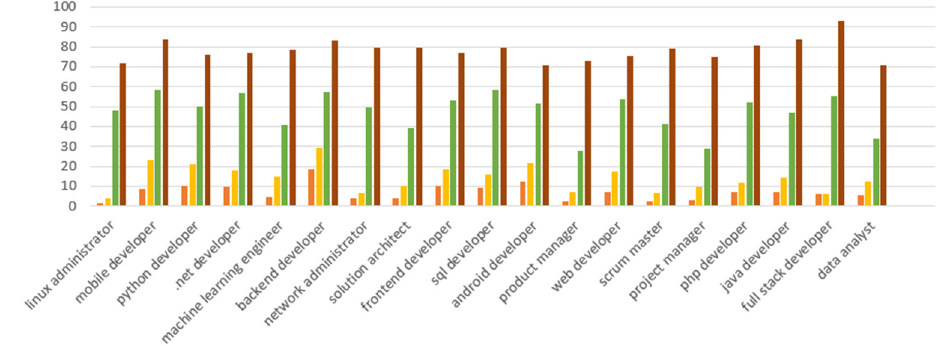
Figure 21. Success rate of finding job requirements for job positions by individual approaches.